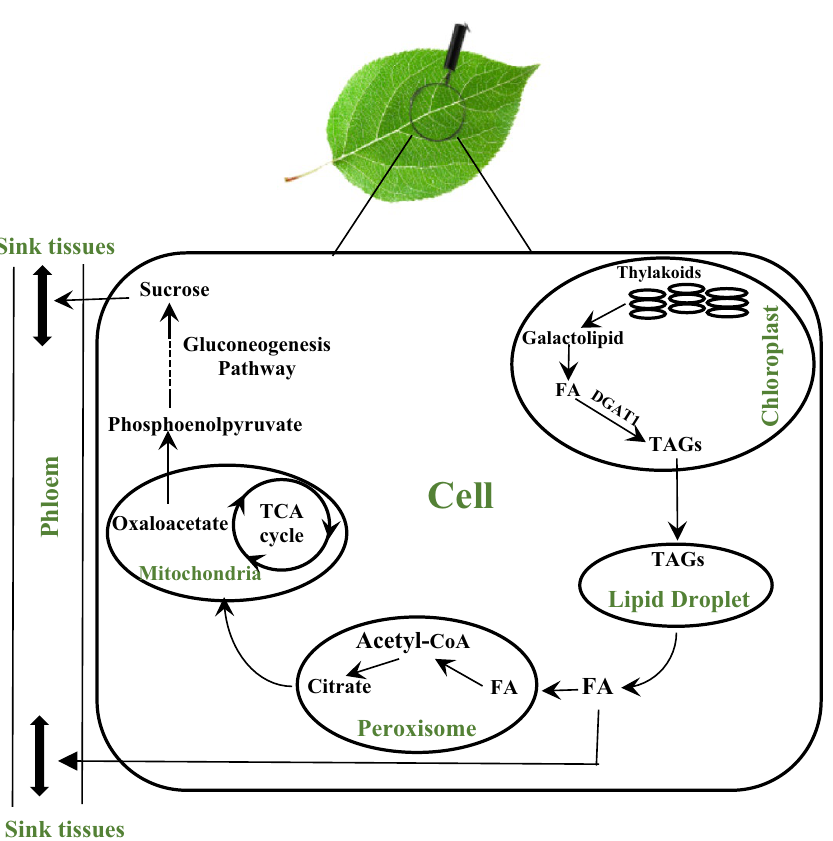
Figure 11. A simplified scheme of pathways involved in the turnover of membrane lipids during leaf senescence followed by translocation of nutrients to sink tissues. Galactolipases release fatty acids from Galactolipid from thylakoid membranes in the chloroplast. Peroxisome produces Acetyl-CoA and Citrate. TCA cycle in the mitochondria produces the essential precursor of Phosphoenolpyruvate through oxaloacetate. The gluconeogenesis pathway in the cytosol also converts phosphoenolpyruvate to sucrose. Phloem translocate all nutrients, including FAs and sucrose to sink tissues like